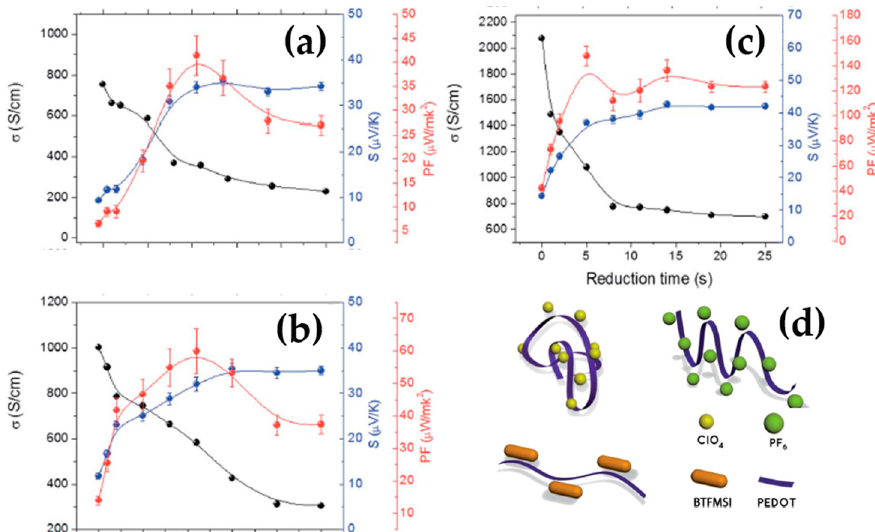
Figure 2. The thermoelectric properties of poly(3,4-ethylenedioxythiophene) (PEDOT):ClO 4 ( a ), PEDOT:PF 6 ( b ), and PEDOT: bis(tifluoromethylsulfonyl)imide (BTFMSI) ( c ) as a function of chemical reduction time using hydrazine. PEDOT conformation in the presence of different counter-ions ( d ). Reprinted with permission from [95]. Copyright 2014 The Royal Society of Chemistry.